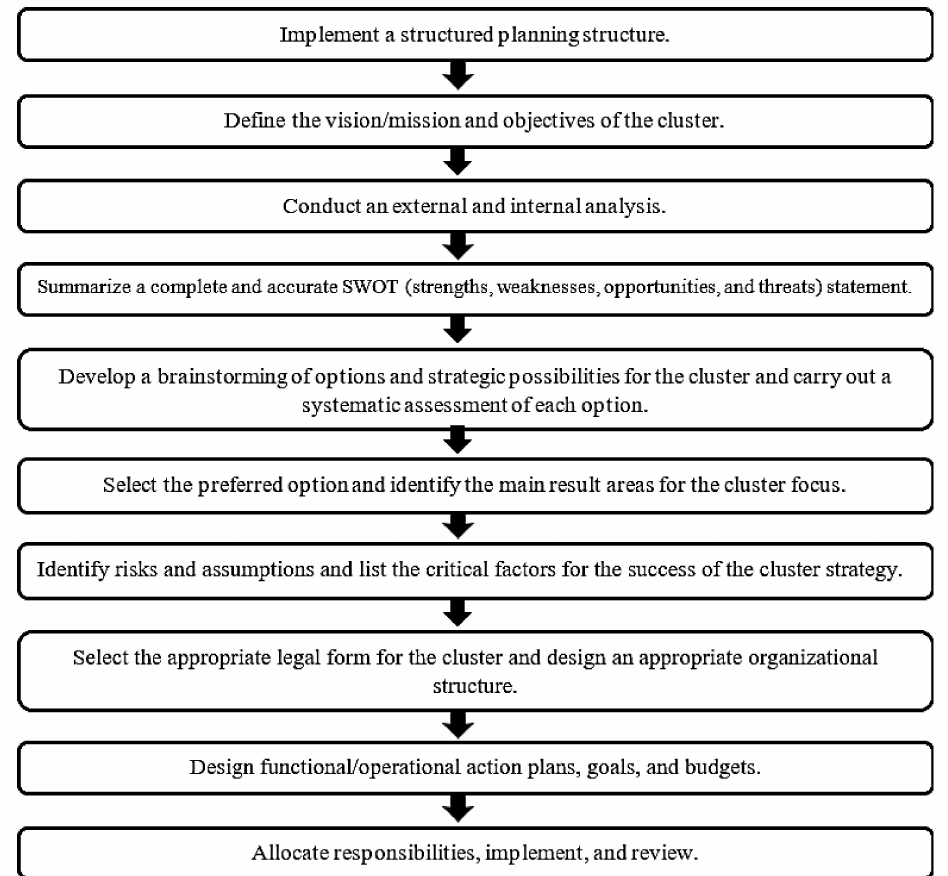
Figure 4. Scheme with guidelines for the implementation of a